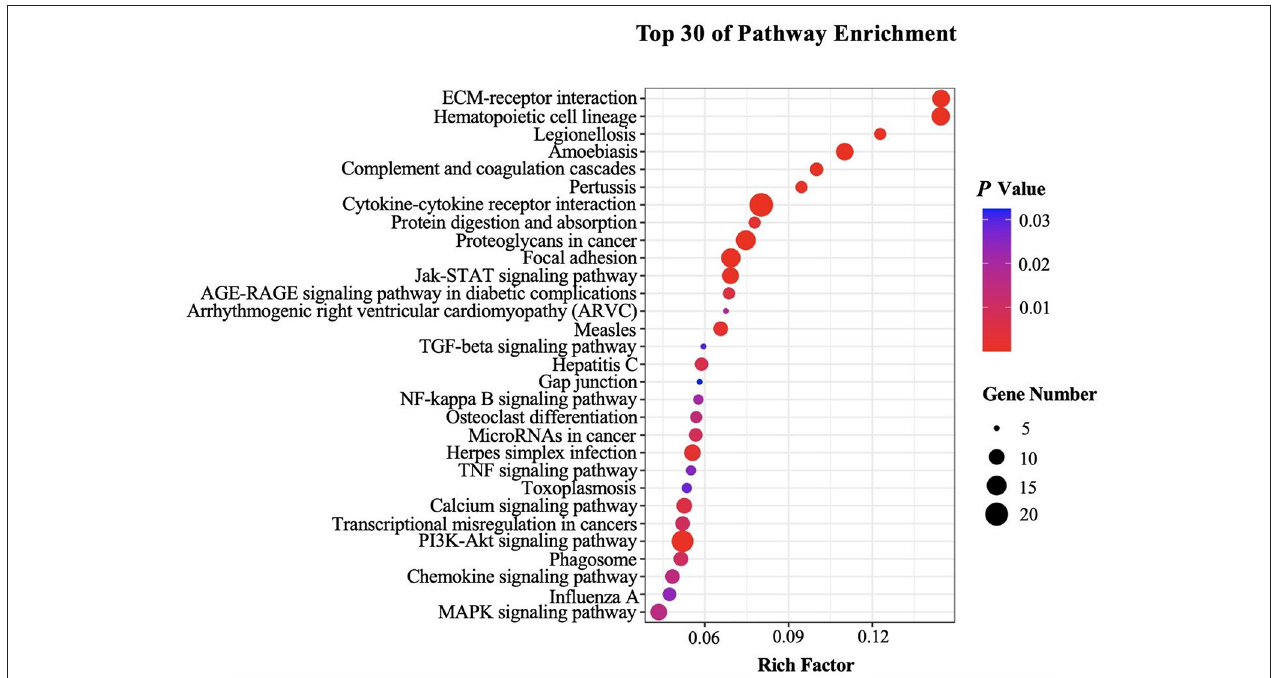
FIGURE 4 | Kyoto Encyclopedia of Genes and Genomes (KEGG) analysis (top 30) of the DEGs in the splenic B cells infected with the larval E. granulosus . The size of each point represents the number of DEGs. The larger the point, the more genes fall into this pathway. Moreover, the point of different colors represents the different P -values, and the greener point means higher significance of enrichment. The rich factor indicates the degree of enrichment.